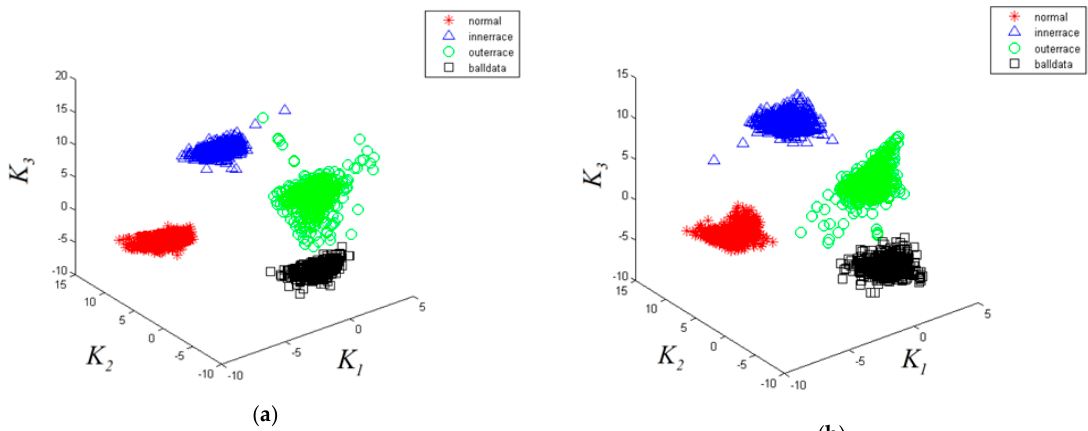
Figure 7. The dimensionality reduction effect of rolling element bearing: ( a ) LLE algorithm, ( b ) M-LLE algorithm.